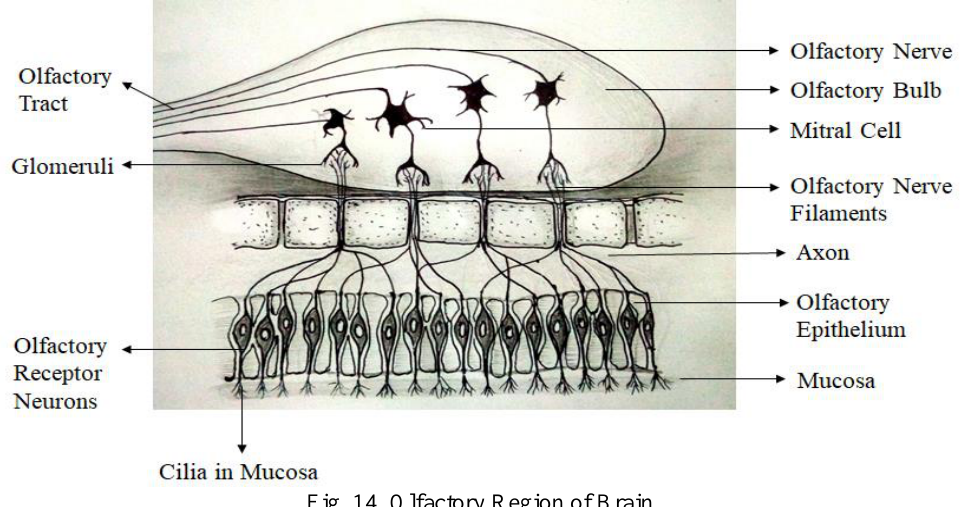
Fig. 14. Olfactory Region of Brain